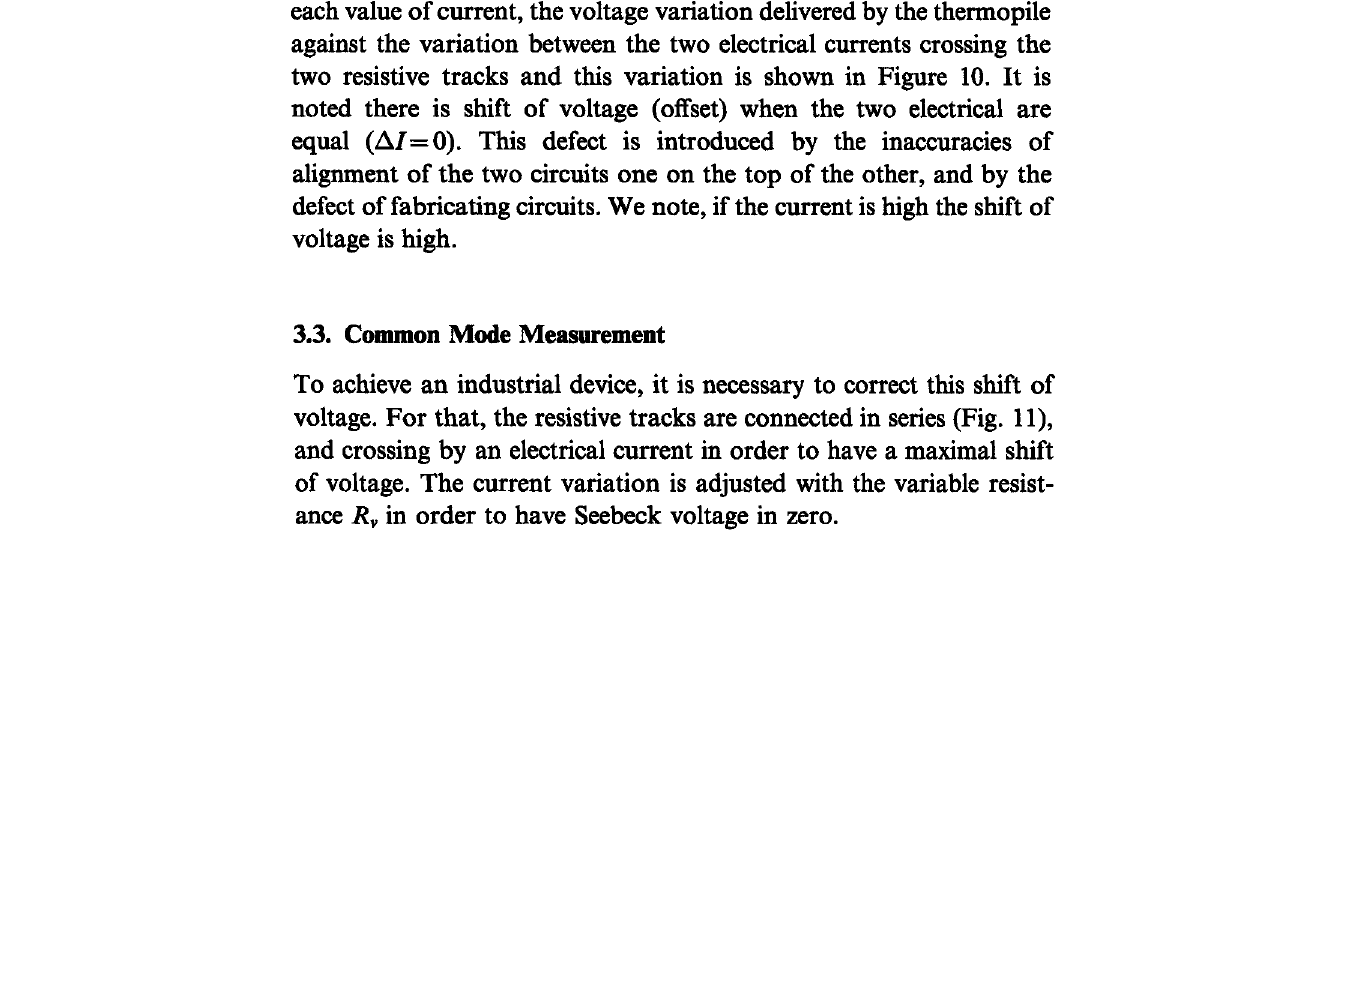
FIGURE 9 Differential mode